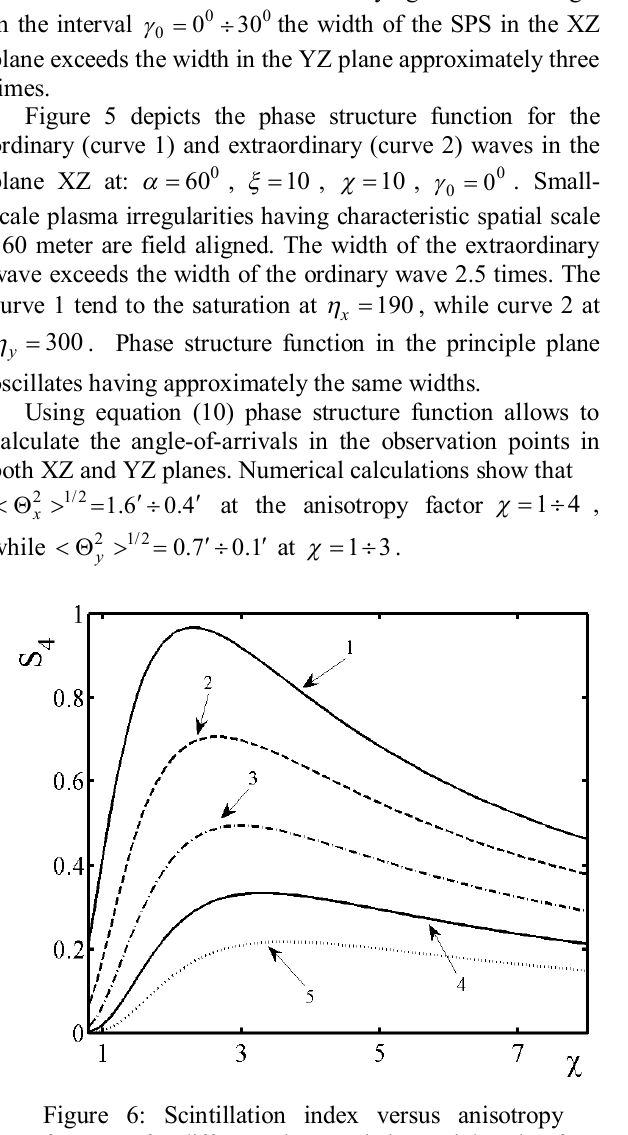
Figure 5: Plots of the phase structure function versus distance between observation points in the XZ